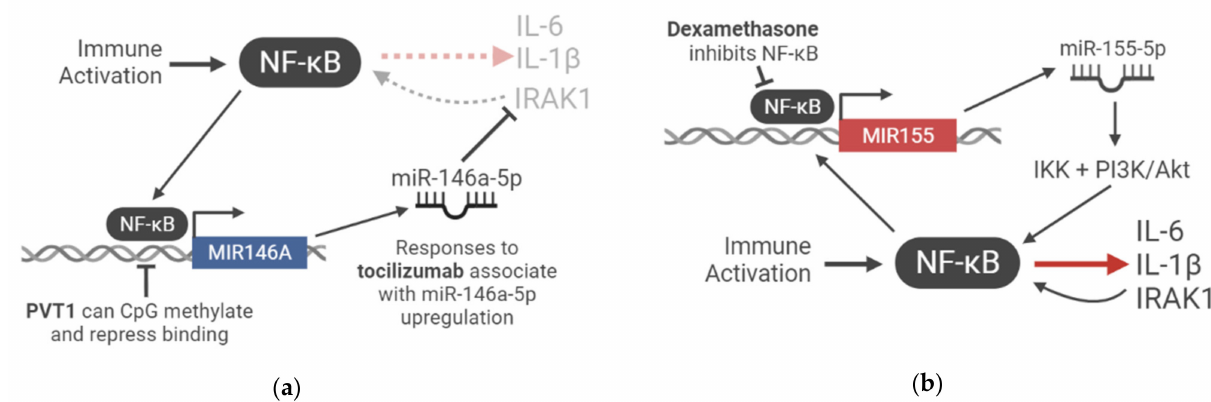
Figure 1. NF- κ B amplification of the immune-activating signal is an integration of ncRNA regulation. ( a ) A negative feedback loop of immunosuppressive ncRNA regulatory balance: NF- κ B signaling induces the transcription of miR-146a-5p, which inhibits IRAK1, a positive regulator of NF- κ B-promoted genes. The result is the downregulation of inflammatory gene expression, such as IL-6, IL-1 β , and IRAK1. The lincRNA PVT1 is associated with promoter CpG methylation and thus the downregulation of miR-146a-5p expression, blocking its immunosuppressive expression; ( b ) a positive feedback loop of inflammatory ncRNA regulatory balance: NF- κ B signaling induces the transcription of miR-155-5p, which further amplifies NF- κ B signaling via IKK and PI3K/Akt, leading to the production of the inflammatory molecules IL-6, IL-1 β , and IRAK1. Dexamethasone treatment can block miR-155-5p transcription by inhibiting NF- κ B